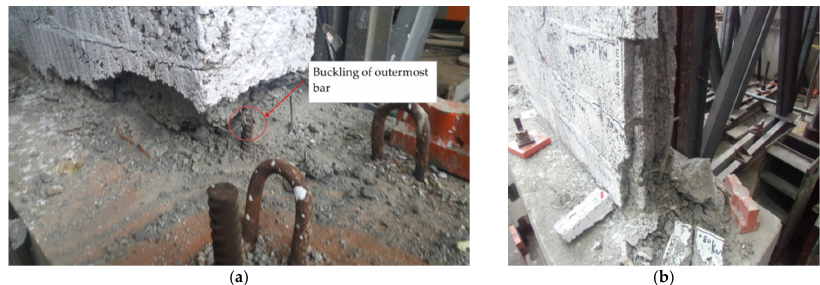
Figure 7. Extent of damage at end of test: ( a ) for wall SW2; and ( b ) for wall SW4.